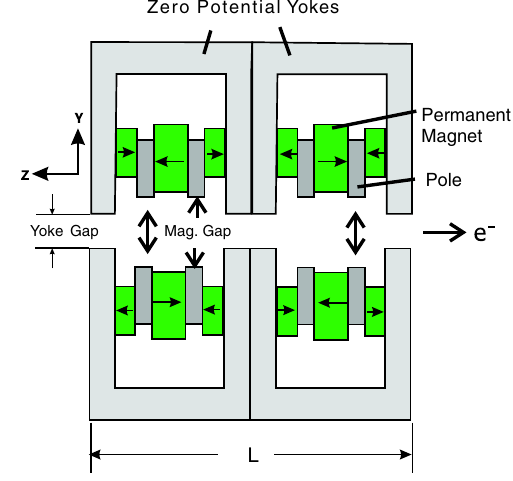
FIG. 1. Magnetic principle of the XFEL phase shifters.